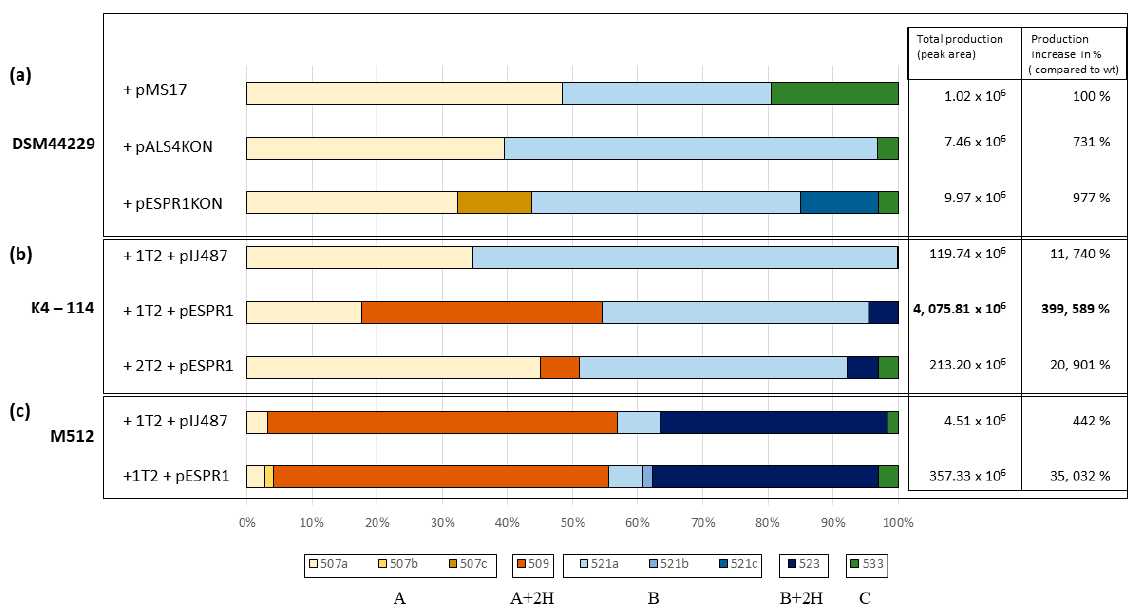
Figure 5. LC-HRMS analysis of the production of manumycin-type compounds encoded by the DSM44229 BGC in various producer strains (ESI − ). The list of strains is provided in the left column, the total amounts of manumycin-type compounds produced (relative amounts reflected by peak areas) and relative production levels calculated as percentages of that in DSM44229 × pMS17 are shown in the right columns. The best producer strain is shown in bold. Composition and ratio of the compounds produced are indicated for each strain in color: compound A in three isomers sharing the same MS/MS fragmentation pattern, but showing different retention times (507a: 7.57 min, 507b: 7.03 min, 507c: 5.72 min); type II form of compound A (A+2H)—two isomers double peak (509: 7.01–7.21 min); compound B in three isomers (521a: 7.94 min, 521b: 7.38 min, 521c: 6.04 min); type II form of compound B (B + 2H)—two isomers double peak (523: 7.36–7.55 min), and the minor congener compound C (533: 8.10 min). ( a ) Saccharothrix espanaensis DSM44229-derived strains, ( b ) Streptomyces lividans K4-114-derived strains, ( c ) Streptomyces coelicolor M512-derived strains. Amounts of the extract loaded were equal to 4 mL of the original post-fermentation culture volumes.